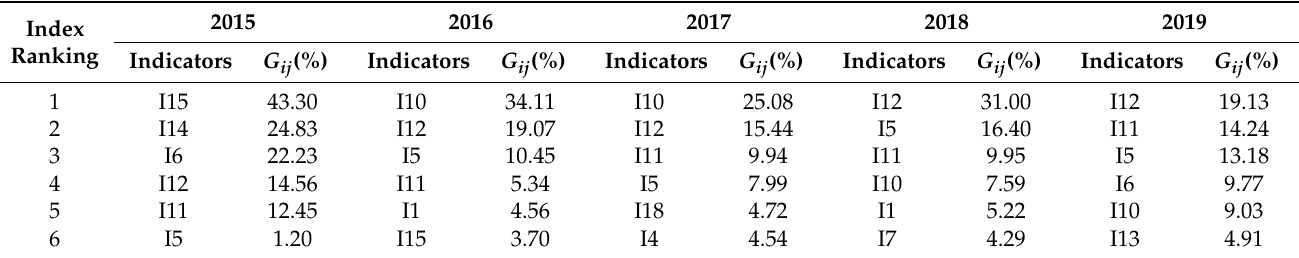
Table 3. Analysis of the barrier degree of each index on C j